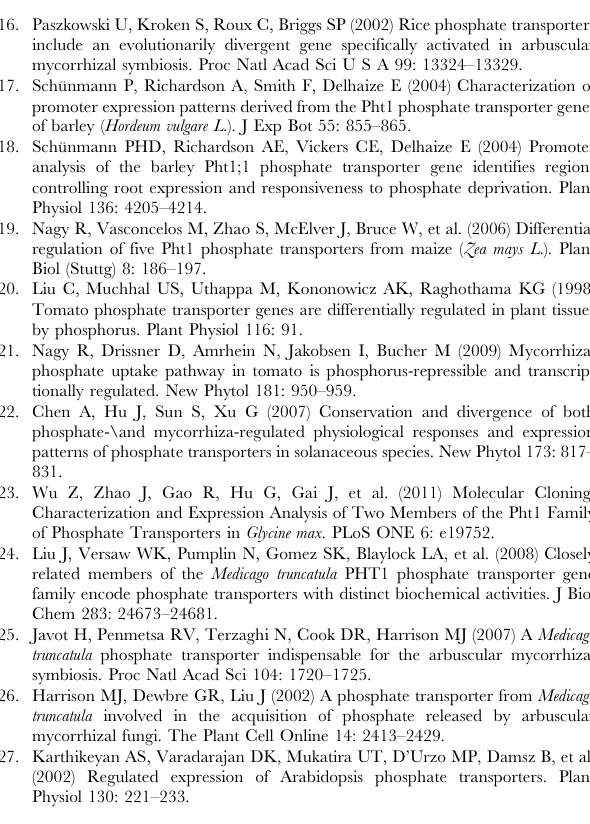
Figure S1 Alignment of amino acid sequences of the Pht1 family phosphate transporters in soybean. Sequence alignment was performed with the ClustalW program [65]. Identical and similar amino acids are shaded in black and grey, respectively. The membrane spanning domains of GmPTs predicted by TopPred (http://www.cbib.u-bordeaux2.fr/pise/ toppred.html) are under lined and numbered by roman numerals (I–XII). (TIF) Figure S2 Schematic diagram of intron/exon structure of GmPT genes. The thin line represents the introns and the open boxes indicate the exons of the respective genes. (TIF) Figure S3 Kinetic growth profiles of yeast transfor- mants. Yeast strains, including WT, empty vector control or Yp112-GmPTs transformants, grew in the logarithmic phase (OD600 < 0.90), then 100 m L different yeast cells were subjected to 3.5 mL YNB liquid medium with different Pi concentrations and incubated at 30 u C, OD 600 were measured every 5 hours up to 25 hours. The Pi concentrations were selected according to their Km values. (TIF) Table S1 Percentage of protein sequences identity among the 14 soybean phosphate transporters in Pht1 family. Table S2 Genes and gene-specific primers used for quantitative real-time PCR experiments.